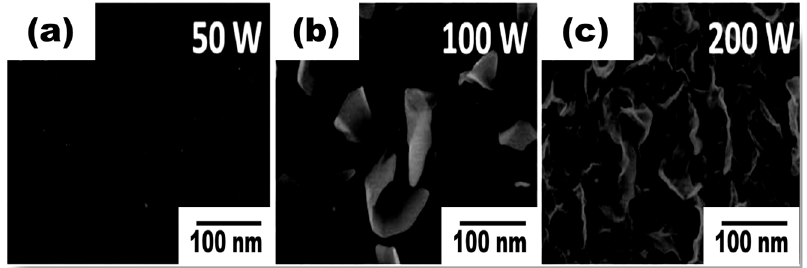
Figure 8. SEM images of GNWs under different plasma power, ( a ) 50 W, ( b ) 100 W, ( c ) 200 W. Reproduced with permission from [93]. Copyright Royal Society of Chemistry 2013.